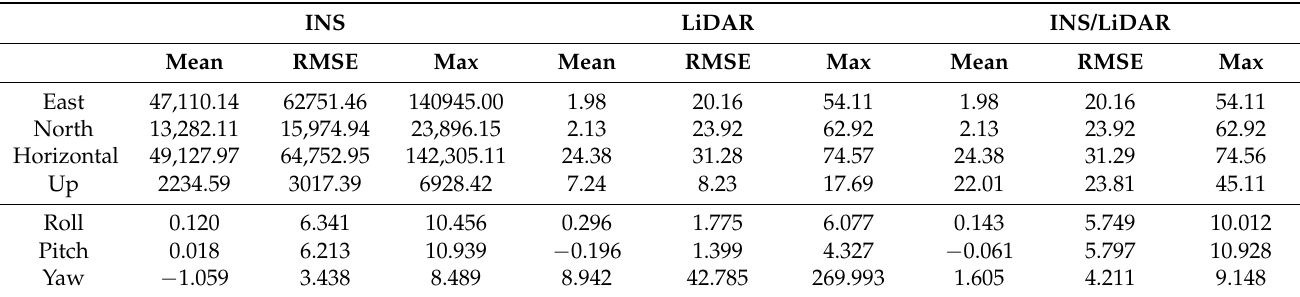
Table A6. D-27_d—position (m) and attitude (deg) error statistics.